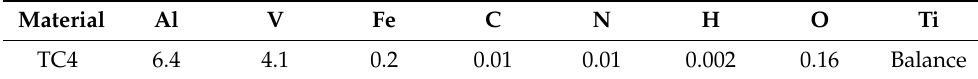
Table 1. Chemical composition of TC4 titanium alloy (in wt %) [6].